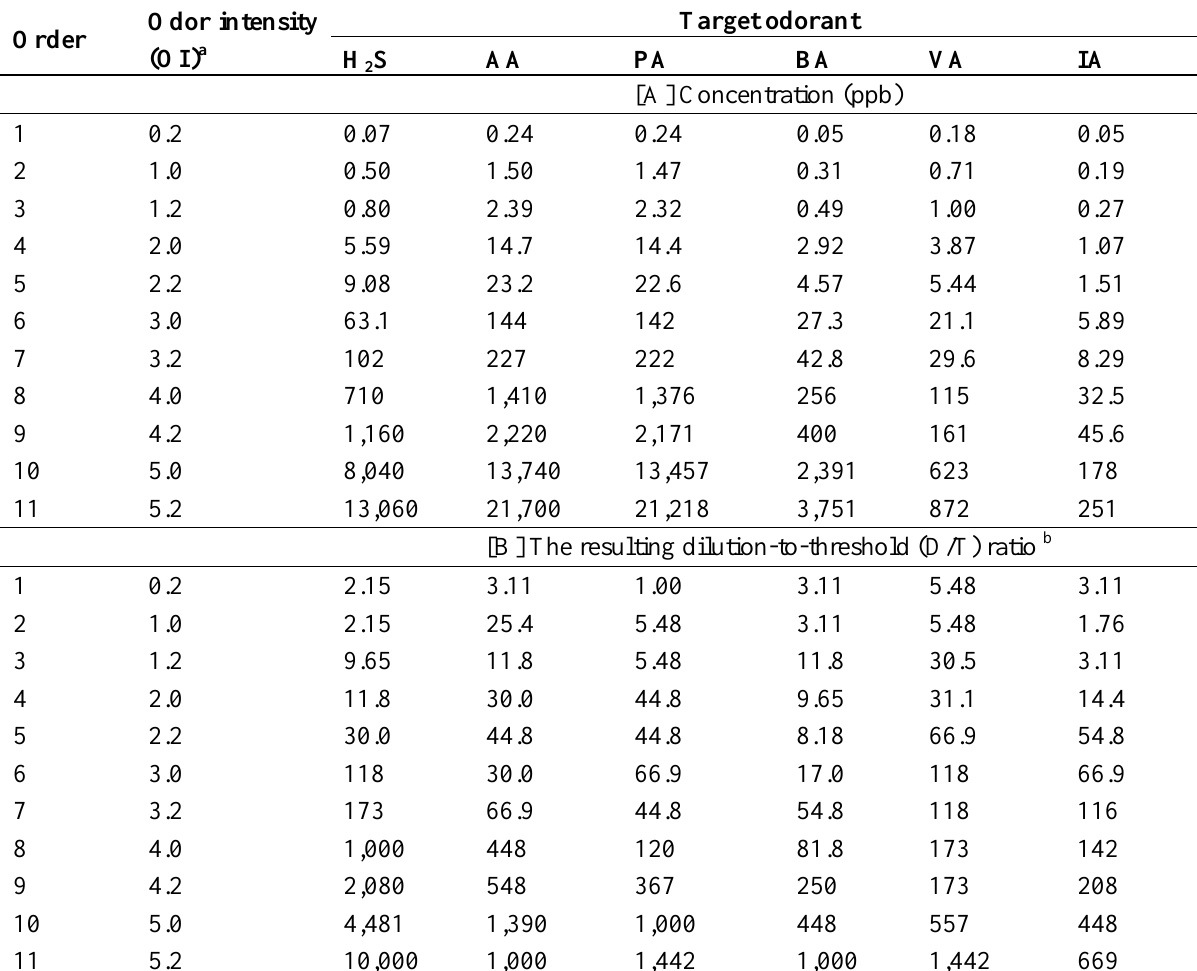
Table 2. Preparation of gaseous standards for each individual odorant to cover a wide range of odor intensities and results of dilution-to-threshold